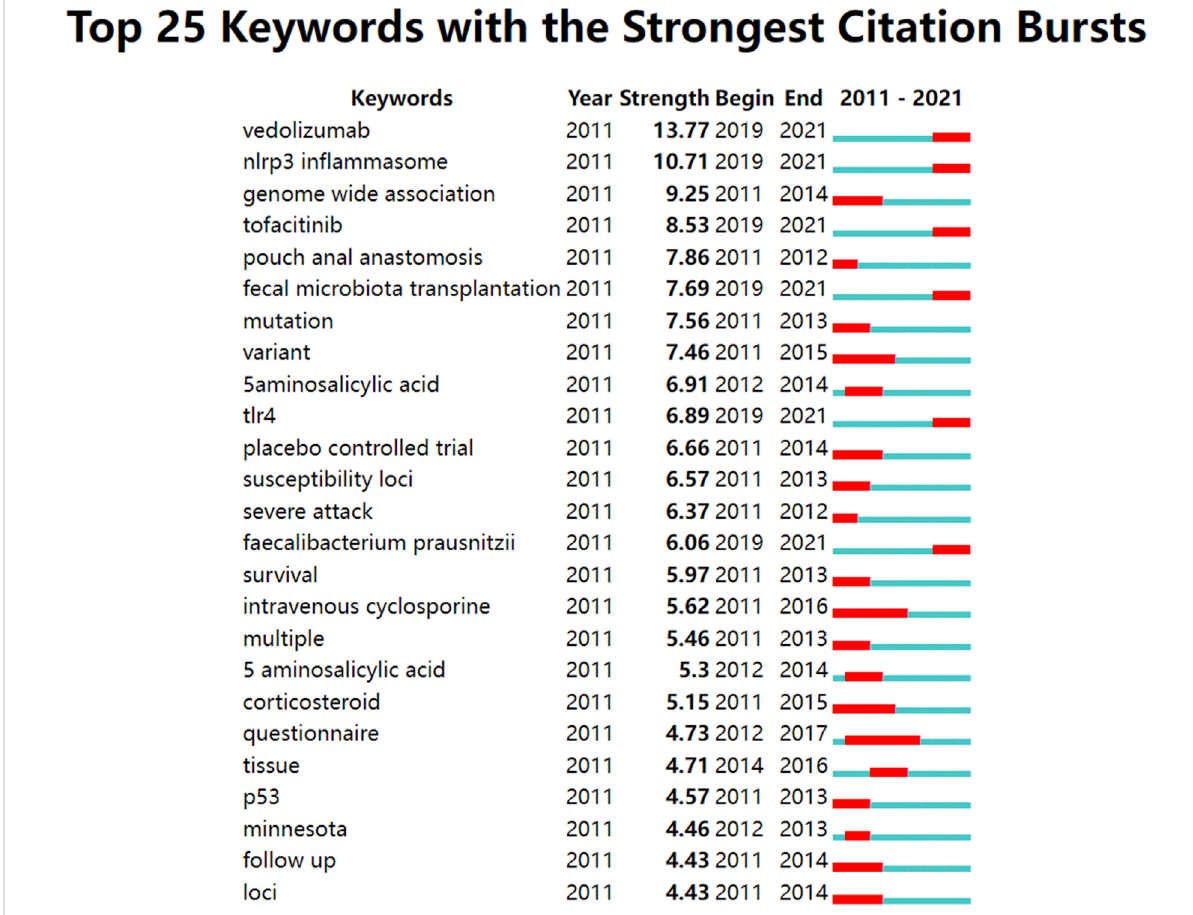
FIGURE 8 Top 25keywordswith strongcitation bursts in UCresearch. Note: As indicated by strength, theburst strength provides a measure of therate of change in citations. The greater strength of a citation burst indicates a sharper upsurge of citations during that time period. There is a thin blue line running from 2011 to 2021, and the red line represents a time slice characterized by a keyword burst, that is, rapid increases in